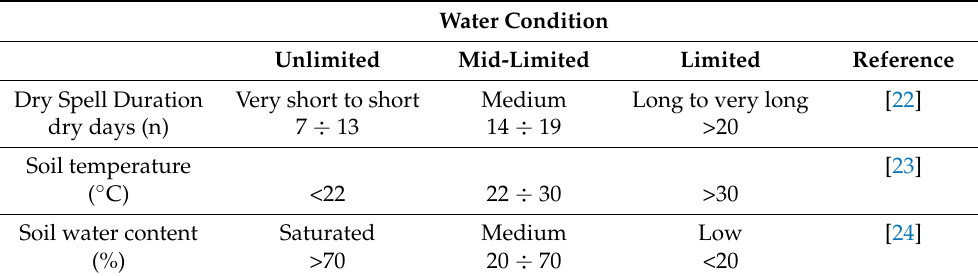
Table 1. Definition of water conditions (unlimited, mid-limited, and limited) according to abiotic parameters: dry spell duration (number of consecutive dry days), soil temperature ( ◦ C), and soil water content (%).